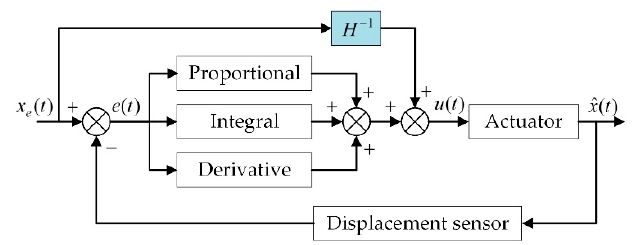
Figure 10. Block diagram of the compound control regime.